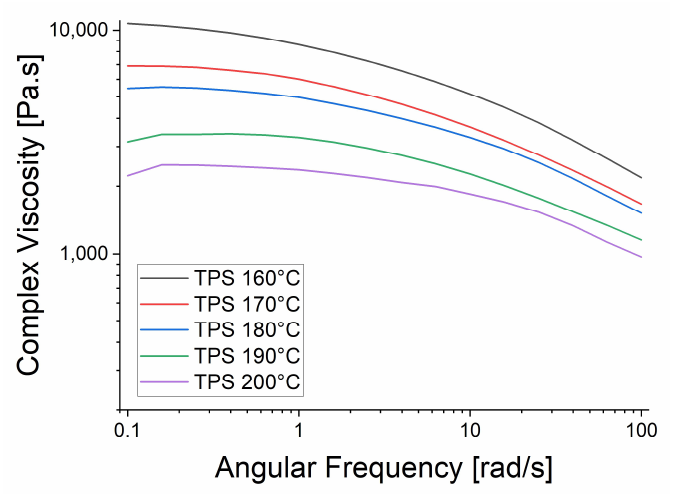
Figure 10. Rheological temperature sweep for